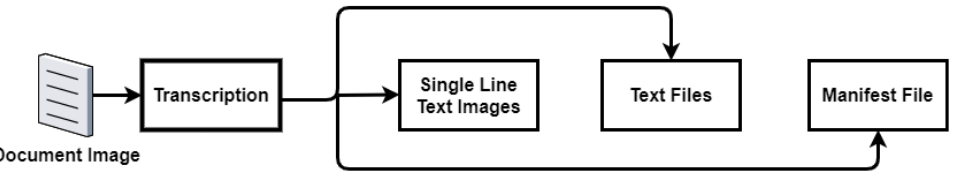
Figure 3. Dataset